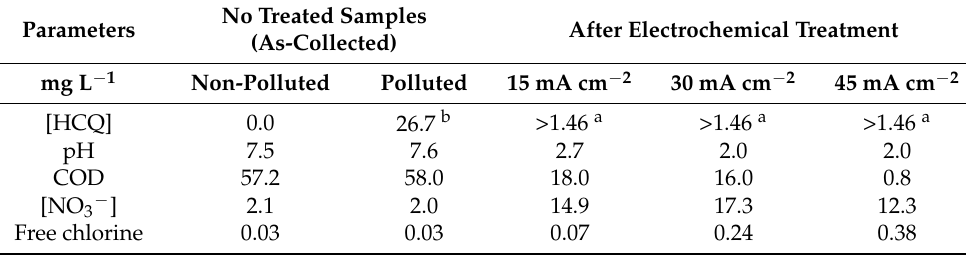
Table 1. Physical–chemical characteristics of the real river samples. Non-electrochemically treated and after electrochemical